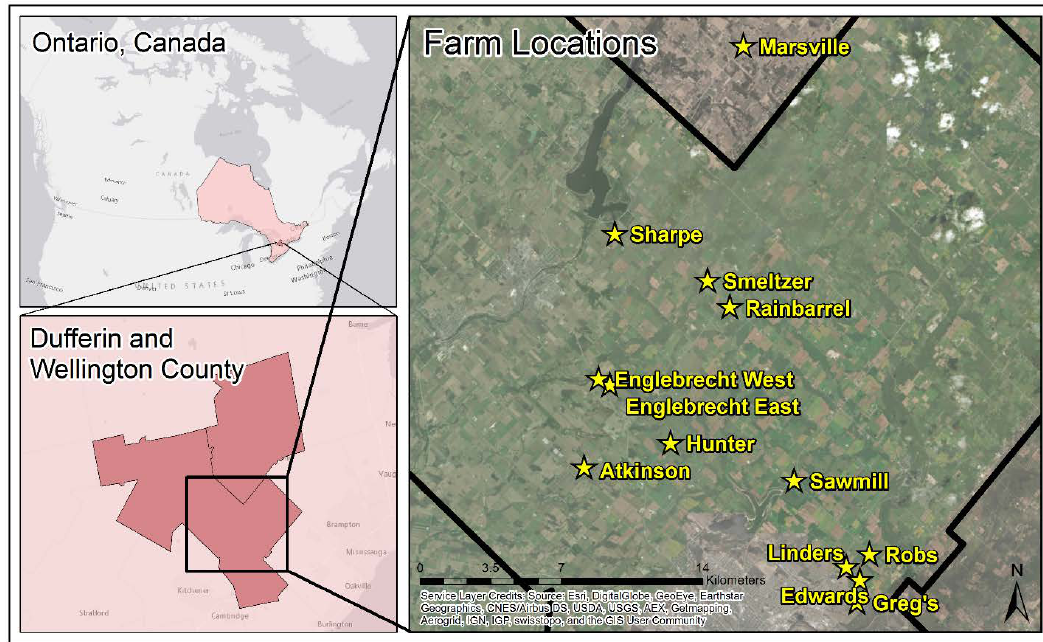
Figure 1. Location of the 13 farms selected for sampling within Dufferin and Wellington County, Ontario, Canada. The black line on the Farm Locations map represents the boundary of Wellington County. The yellow stars and yellow text represent the locations of the farms where soil samples were collected.